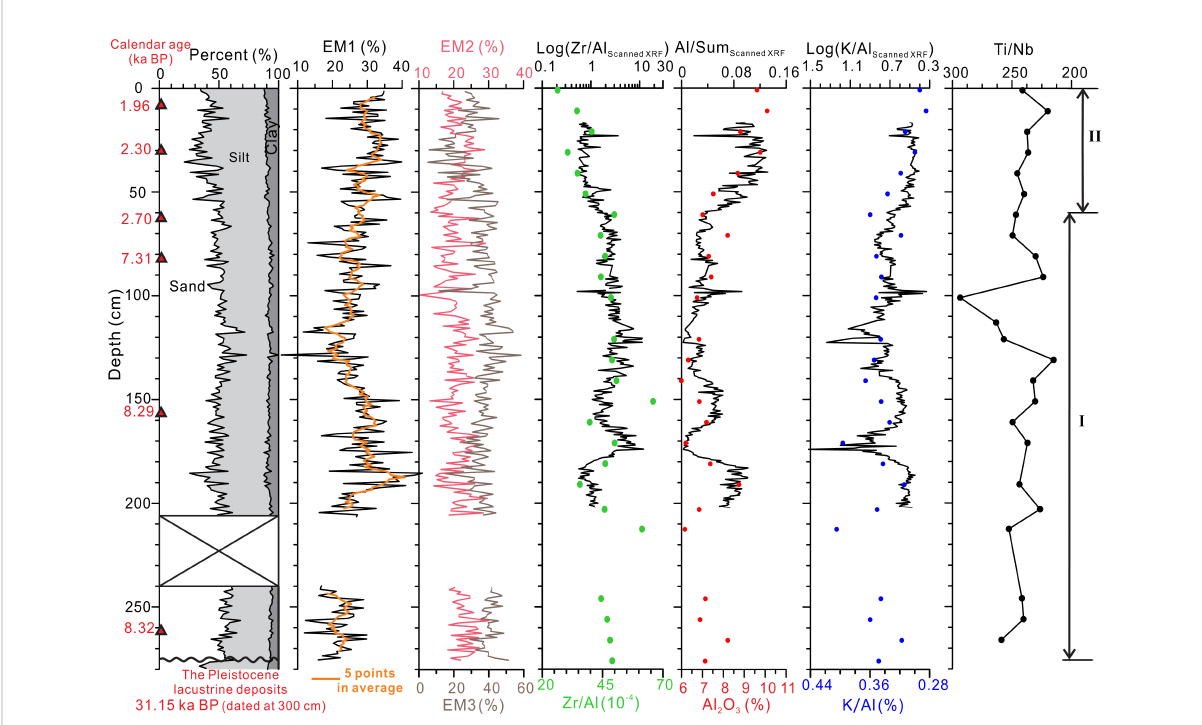
FIGURE 4 Sedimentary compositions and elemental proxies of core YX03. Elemental results of discrete samples were shown by solid dots on down-core elemental pro fi les collected by the XRF scanner. Red triangles on the depth scale mark 14 C dating samples. Sub-segments are labeled on the right